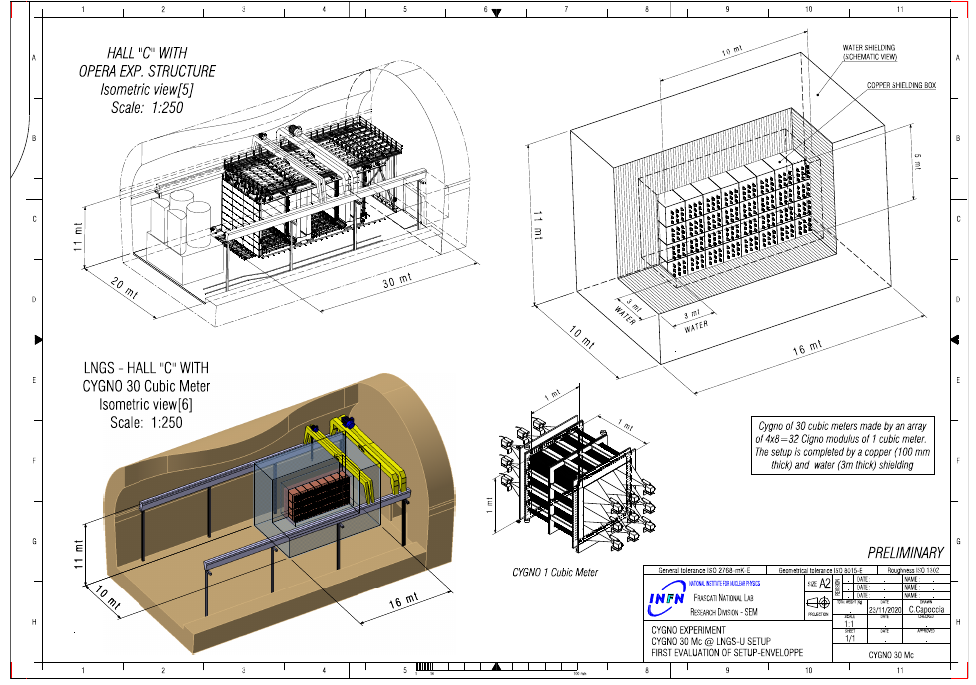
Figure 11. CYGNO PHASE_2 possible